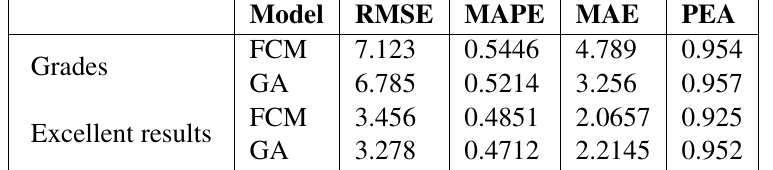
Table 4 Summary of the results of the two models’ prediction statistical